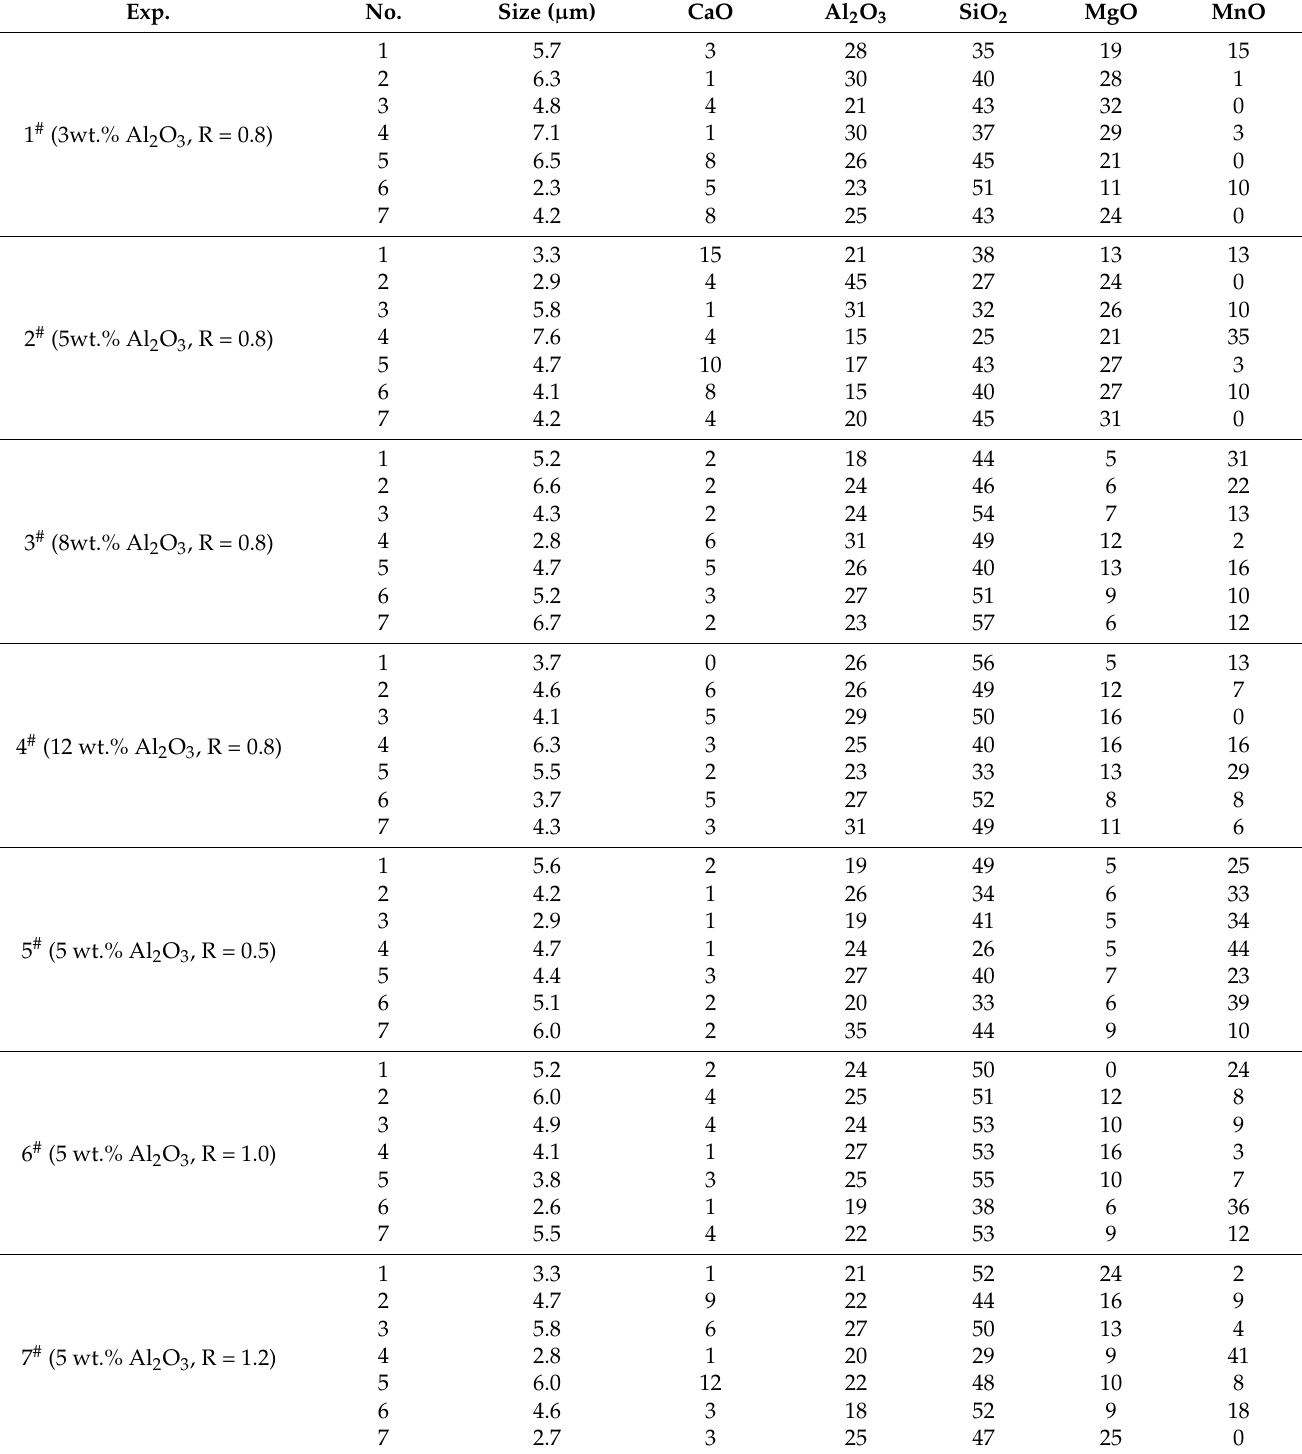
Table 6. Chemical compositions of typical inclusions in the experimental steel samples (mass fraction, %).